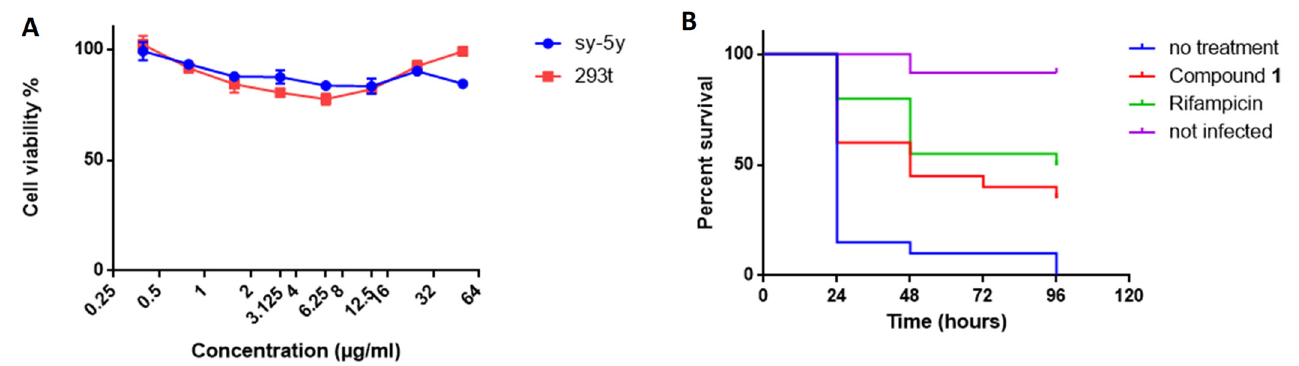
Figure 6. Assessment of cytotoxicity and Galleria treatment with compound 1. ( A ) Cytotoxicity of compound 1 evaluated over a wide range of concentrations (50–0.2 µ g/ml) against two mammalian cell lines (Sh-SY5Y and HEK 293T) by MTT assay. ( B ) Kaplan–Meier survival curves of Galleria mellonella larvae infected with M. bovis BCG and treated 2 h later with vehicle (6% DMSO) as a negative control, rifampicin as a positive control, and compound 1